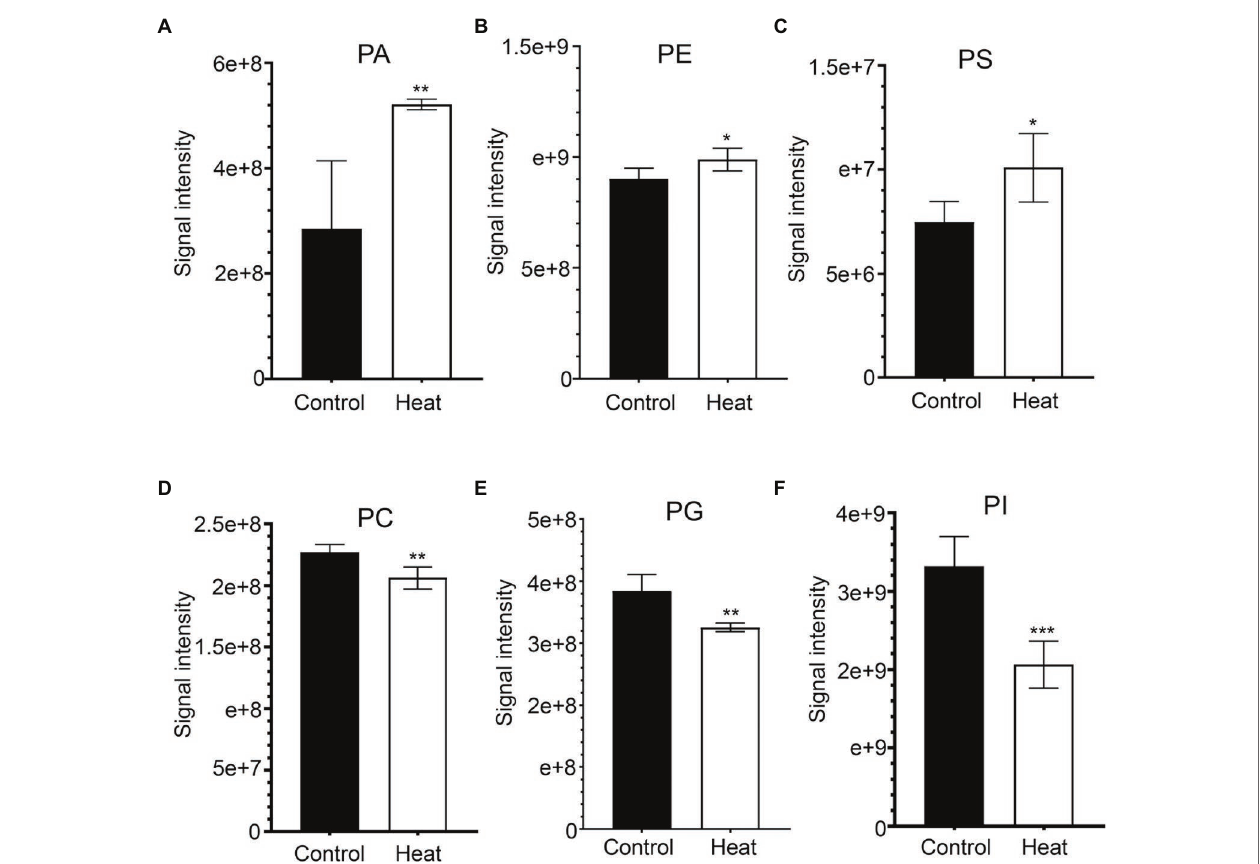
FIGURE 4 | Heat-induced alterations in the levels of phospholipids in leaves of B. grandis . Fully extended leaves detached from 173-d-old plants of B. grandis were at control condition (22 ° C for 2 h) or challenged with heat stress (45 ° C for 2 h). (A) PA, phosphatidic acid; (B) PE, phosphatidylethanolamine; (C) PS, phosphatidylserine; (D) PC, phosphatidylcholine; (E) PG, phosphatidylglycerol; (F) PI, phosphatidylinositol. Values shown are mean ± SD ( n = 5). * p < 0.05, ** p < 0.01, *** p < 0.001, two-sided Student’s t -test.